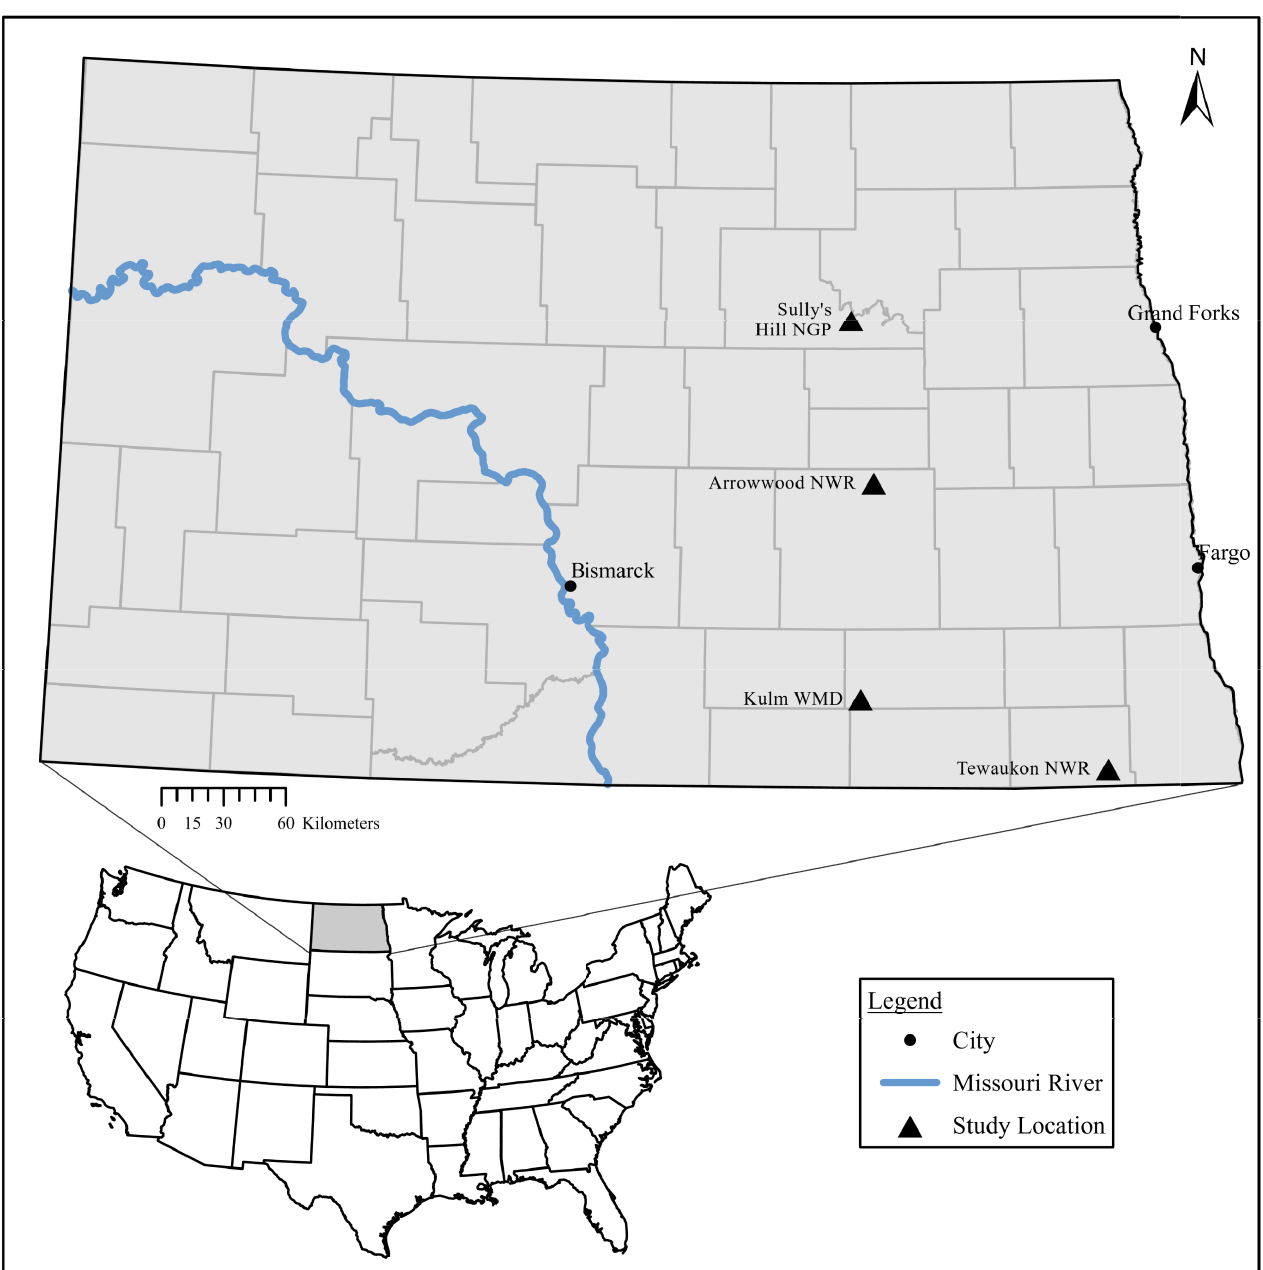
Fig 1. Study locations in eastern North Dakota. At each location two study sites were chosen, a native prairie grassland located on United States Fish and Wildlife Service managed lands and an adjacent restored prairie grassland enrolled in the United States Department of Agriculture’s Conservation Reserve